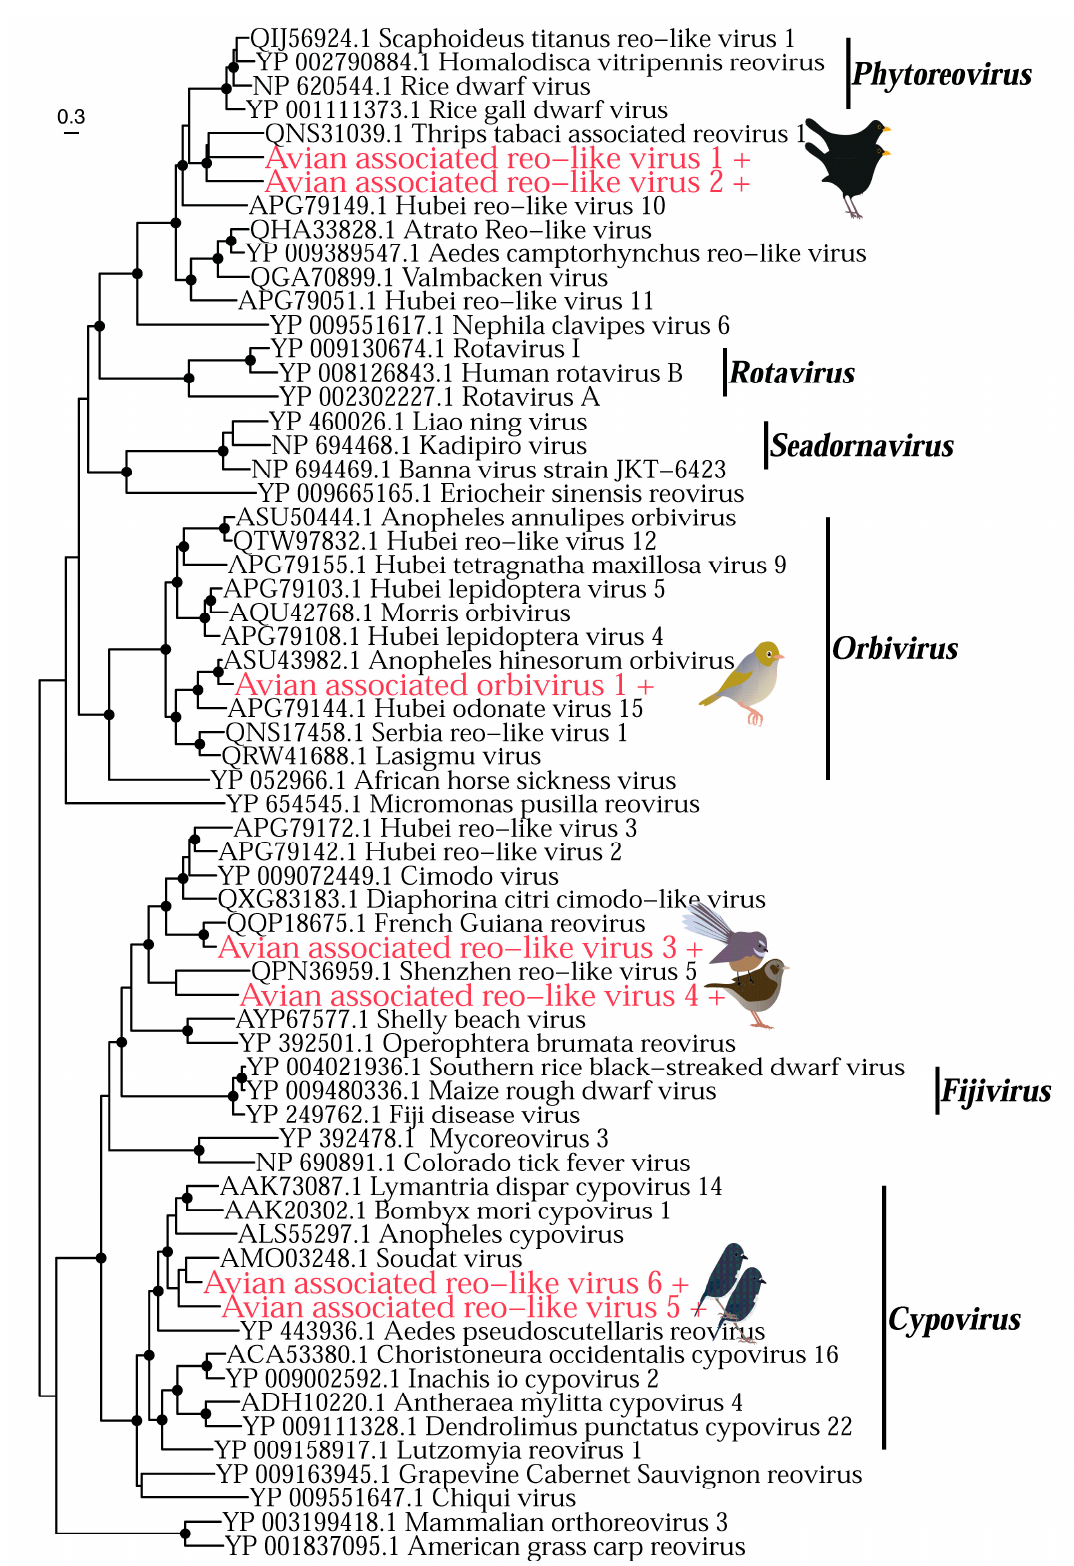
Figure 11. Phylogeny of the Reoviridae based on the RNA-dependent RNA polymerase gene (align- ment length of 684 amino acids). Colours and symbols as shown in Figure